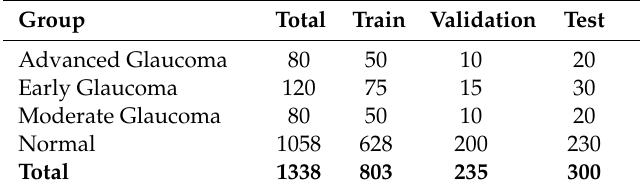
Table 3. Distribution of images in the di ff erent Groups (Classes) and